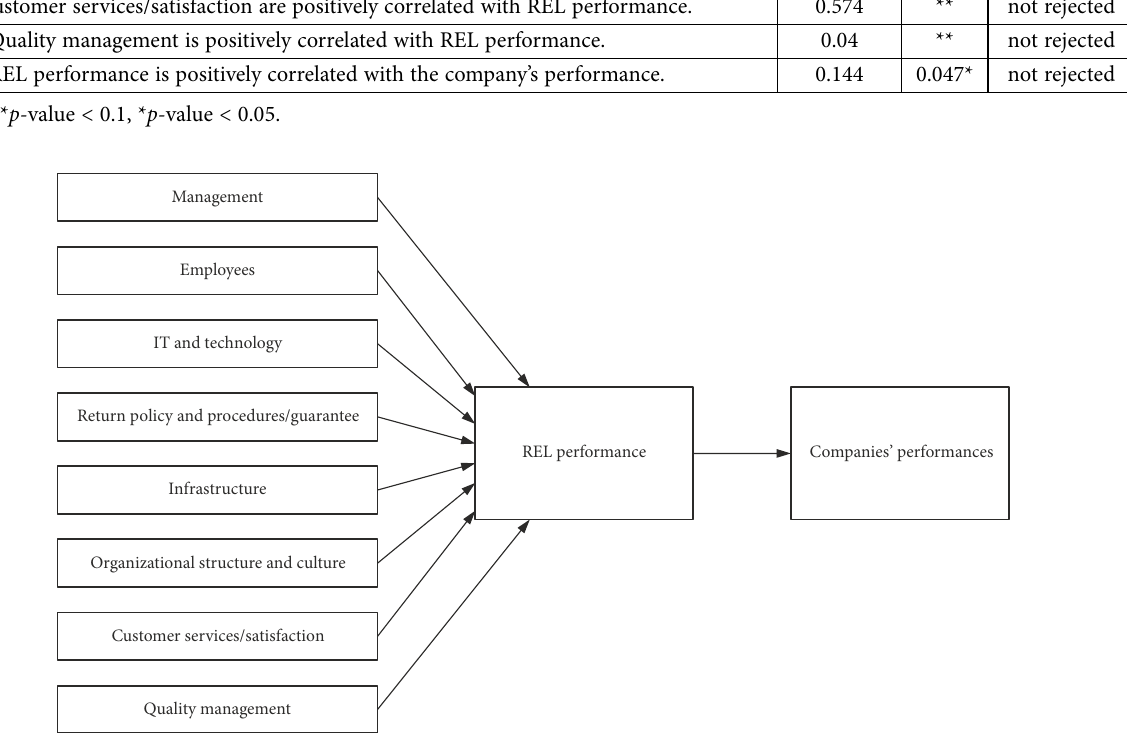
Figure 4. The concluding model for increasing REL performance (source: compiled by authors